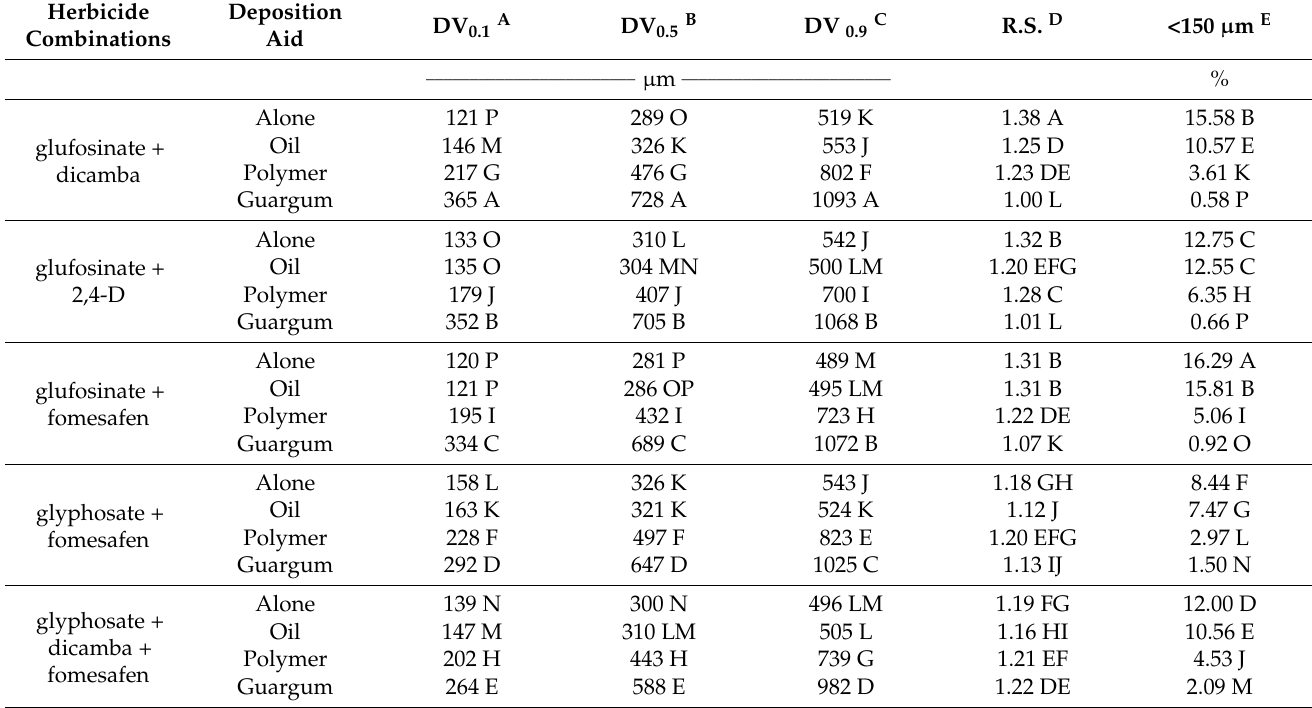
Table 11. Effect of soybean herbicide combinations and deposition aids on spray D V0.5 , D V0.1 , D V0.9 , relative